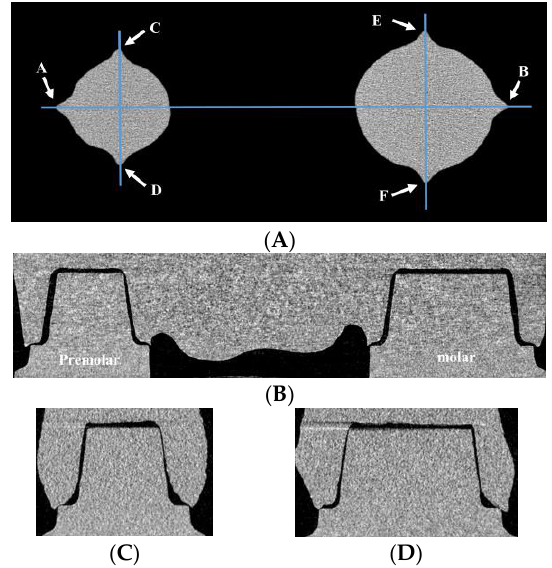
Figure 4. ( A ) A horizontal plane containing reference points A to F on CT data was defined as a reference plane. On the reference plane, a blue line containing reference points A and B indicates the coronal section. Another line containing reference points C and D indicates the premolar sagittal section and the other line containing reference points E and F indicates the molar sagittal section. ( B )